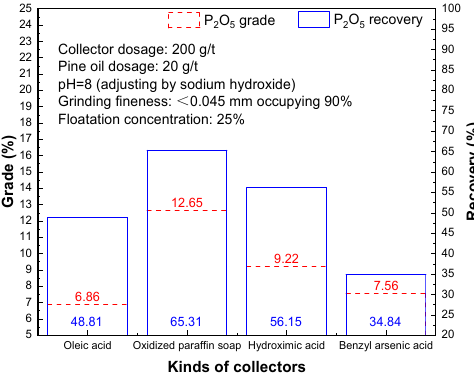
Figure 2. E ff ect of di ff erent collectors on extracting Figure 2. Effect of different collectors on extracting phosphorous.